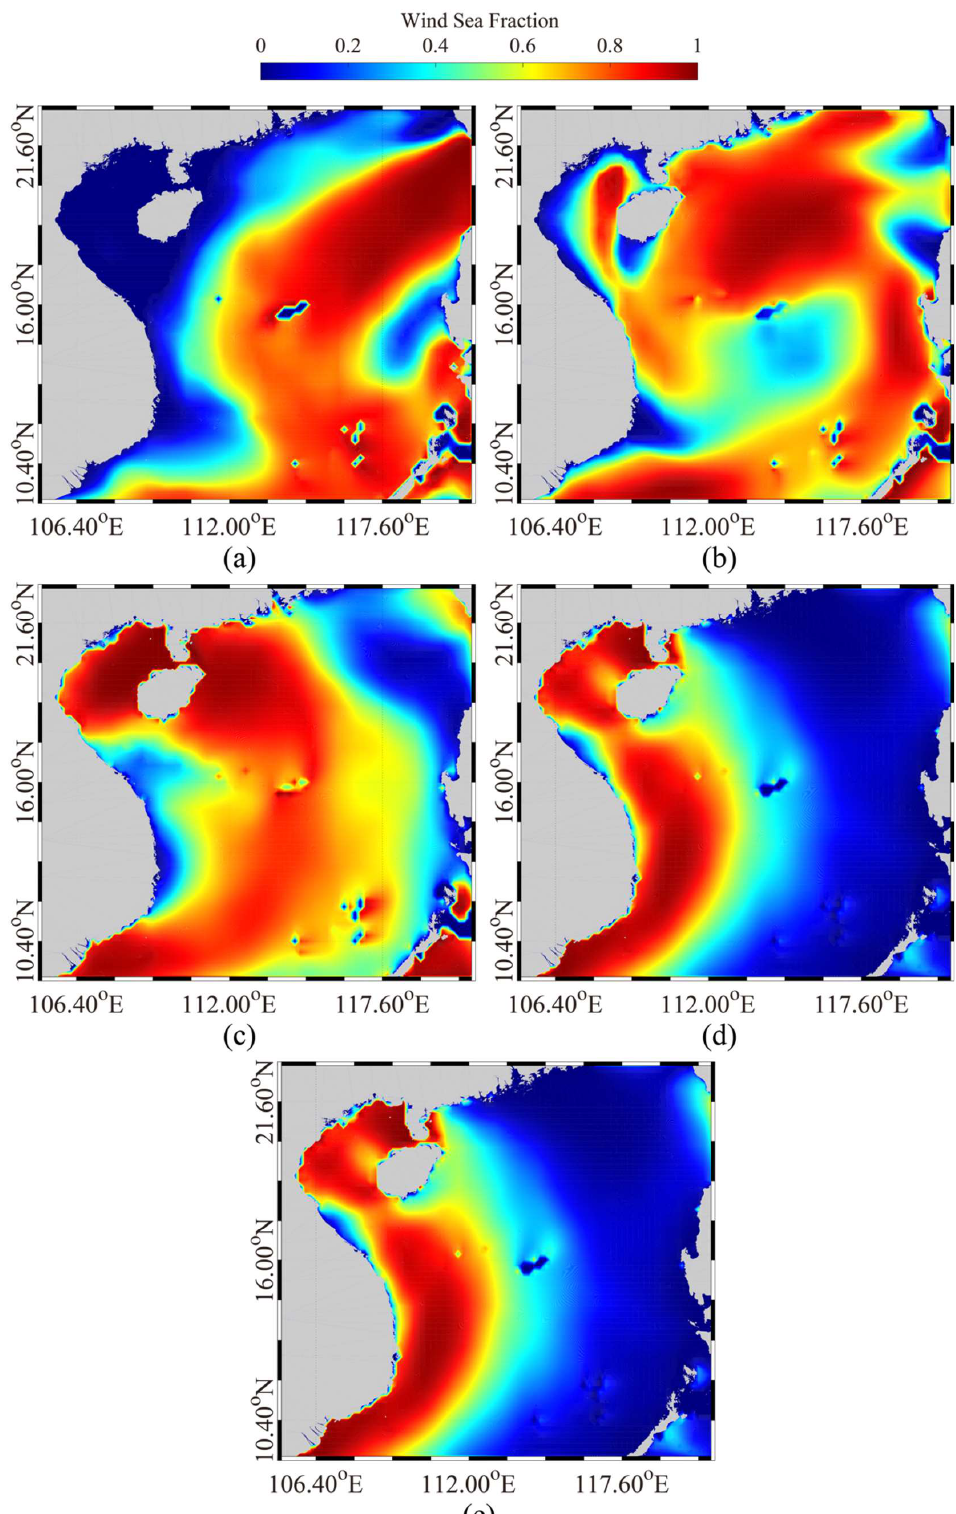
Figure 13. Daily mean wind-sea fraction of Typhoon Doksuri from 12 September 2017 to 16 September 2017. ( a ) on 12 September; ( b ) on 13 September; ( c ) on 14 September; ( d ) on 15 September; and ( e ) on 16 September.